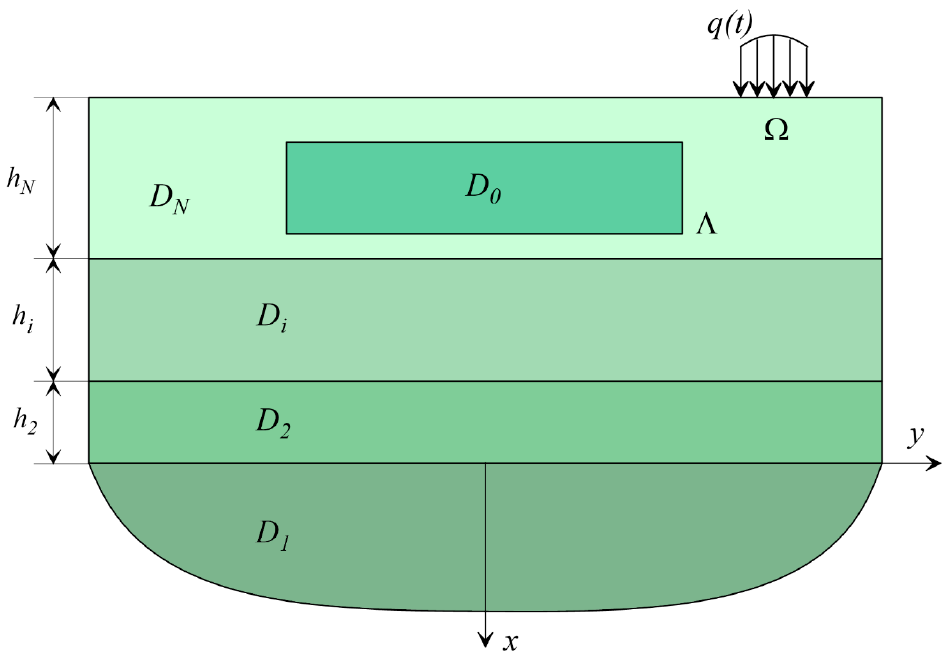
Figure 1. Layered half-space scheme with an arbitrary underground structure.